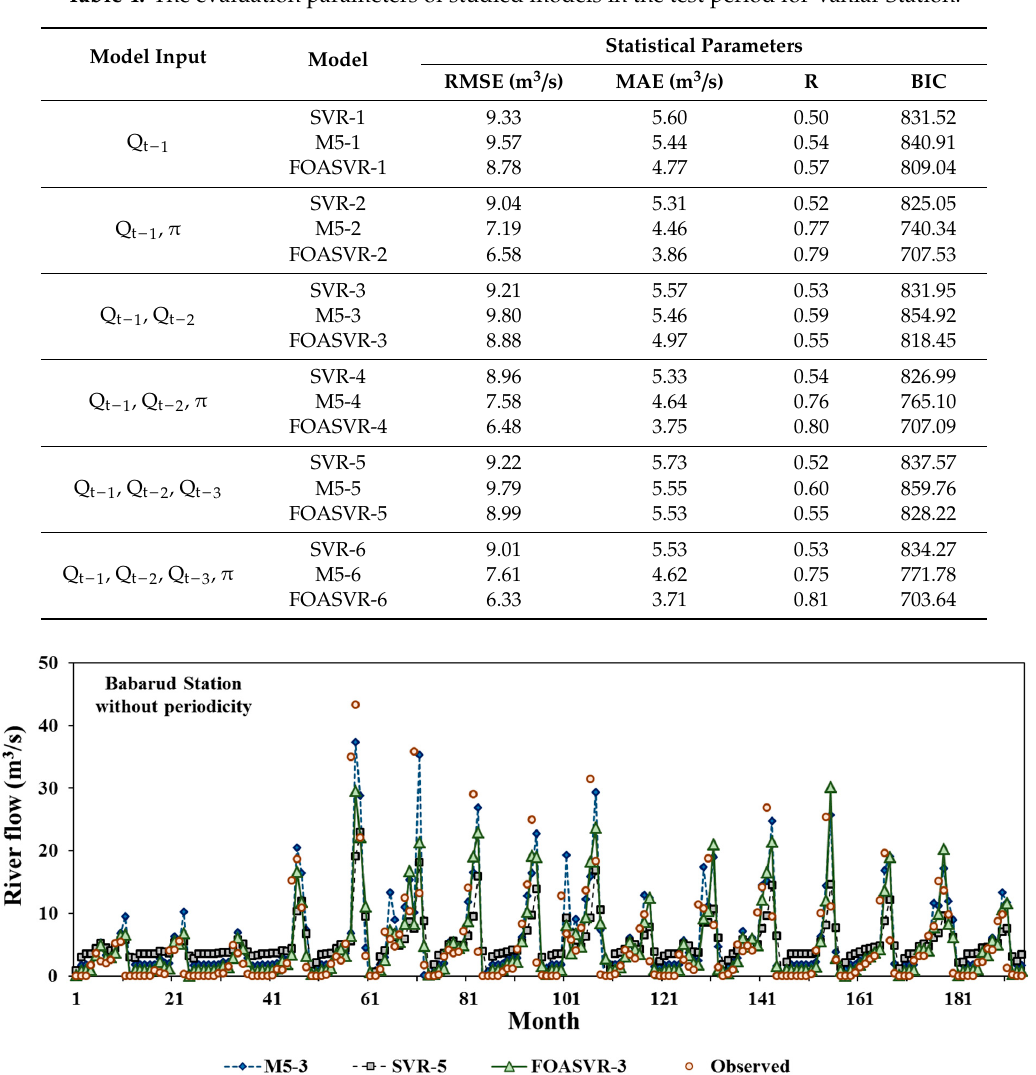
Table 4. The evaluation parameters of studied models in the test period for Vaniar Station.